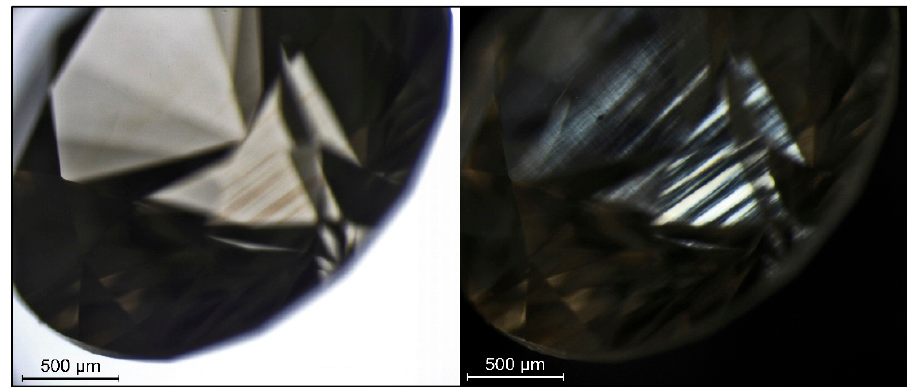
Figure 25. A brown type IIb diamond (sample TH 2.610) in immersion (left) showing the characteristic plastic deformation-related brown “graining” along (111), and the corresponding extinction patterns as shown under crossed polarizing filters (right), equal to what is seen in type IIa diamonds.